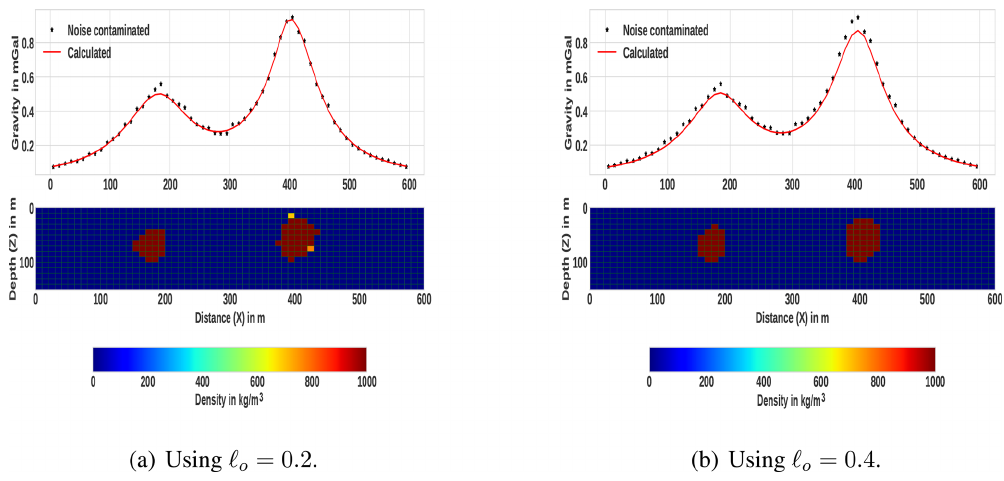
Figure 4. Inversion results, using different (cid:96) o values, for the first synthetic model given in Fig.